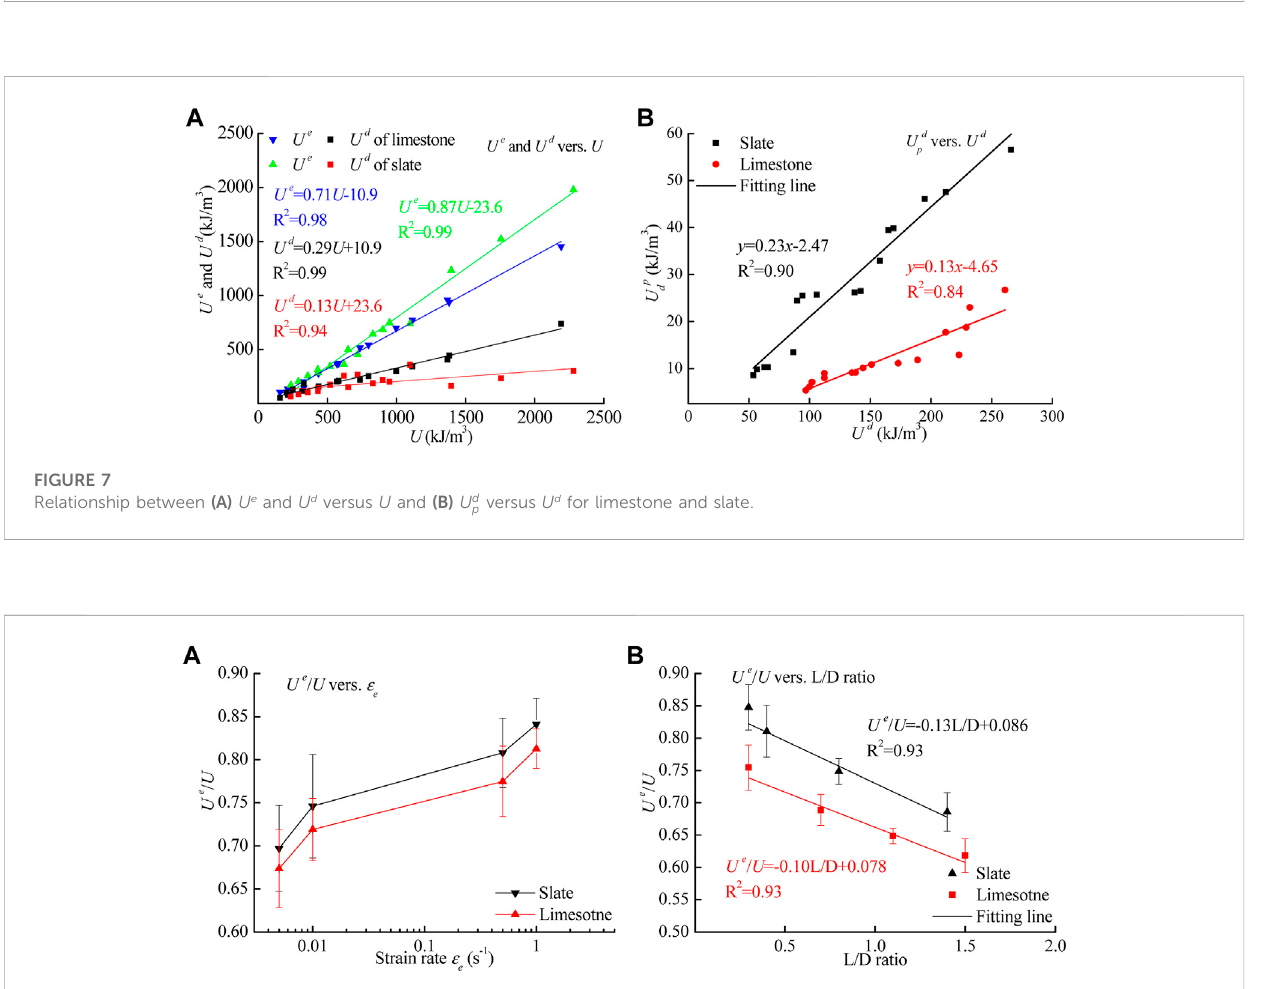
FIGURE 8 Effect of the strain rate and L/D ratio on the linear energy characteristics. (A) strain rate and (B) L/D